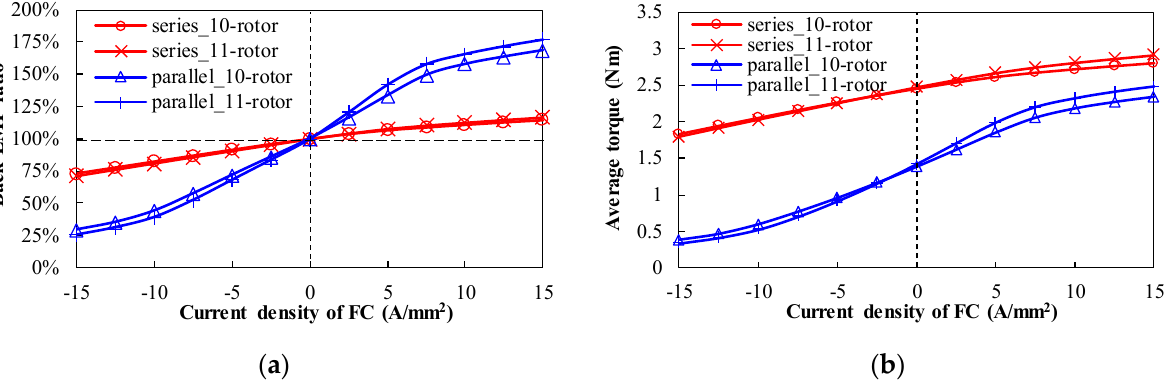
Figure 14. Flux regulation and torque capabilities of series and parallel HE machines. ( a ) Variations of back ‐ EMF ratio versus field current. ( b ) Variations of average torque versus field current.